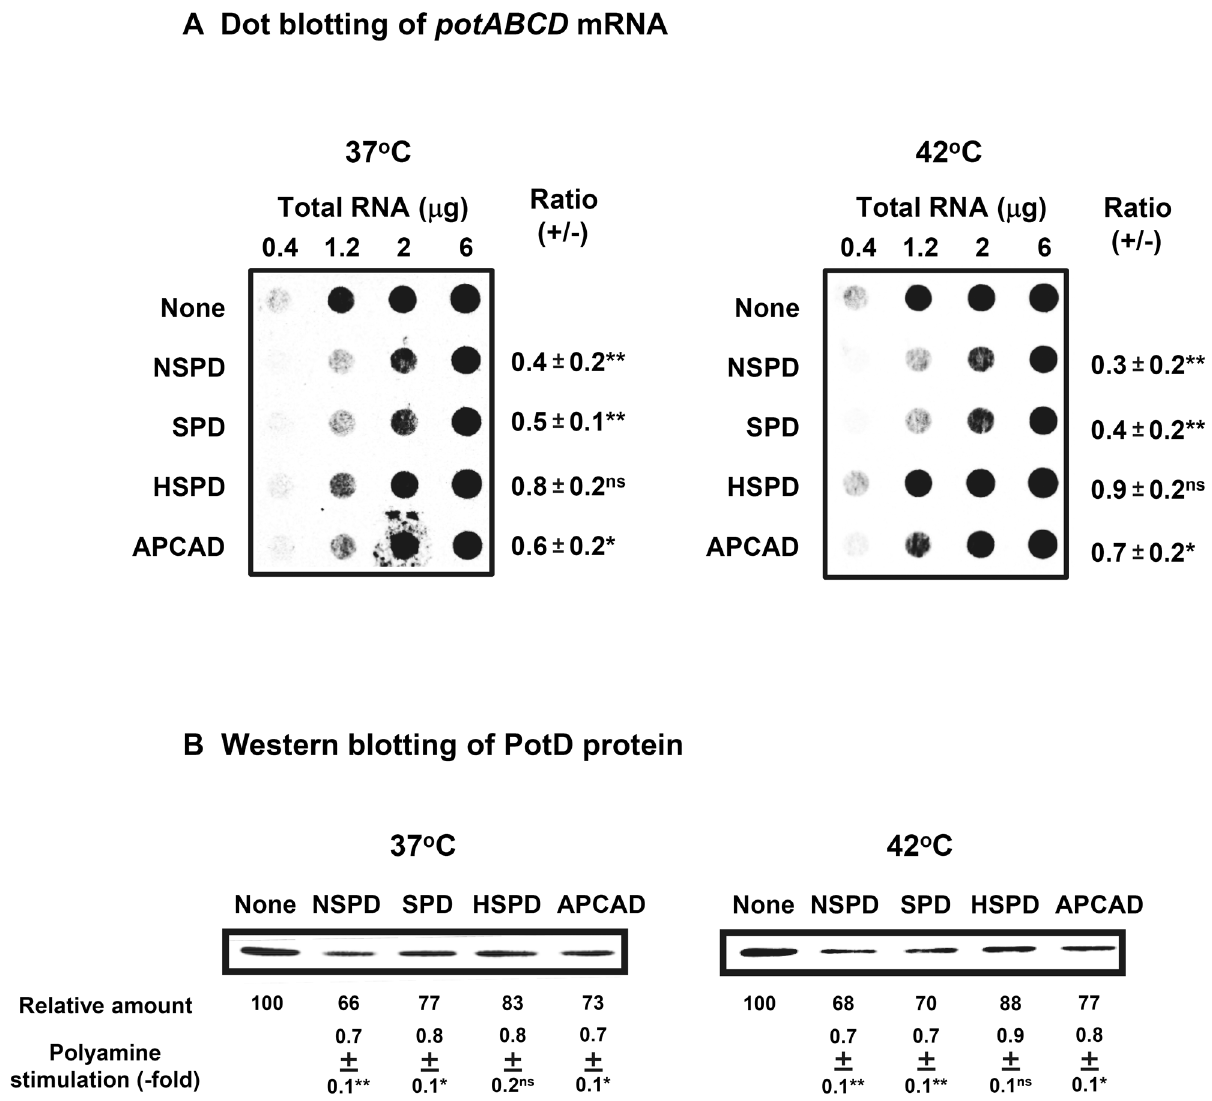
Fig 4. Levels of potABCD mRNA and PotD protein in E . coli MA261 cultured in the presence and absence of triamines. Cells were harvested at A 540 = 0.3. A. The level of potABCD mRNA was measured by dot blotting [12]. The probe for dot blotting was prepared by PCR using primers, 5 ’ -CGACTTACGAGTCGAACGAAACCATGTACG-3 ’ and 5 ’ -AGAACCGTTCCAGATCATGCCGAGGTTAAC-3 ’ . B. The level of PotD protein was measured by Western blotting using 10 μ g protein. Values are mean ± S. E. of triplicate determinations. ns, p (cid:1) 0.05; * , p < 0.05; ** , p <